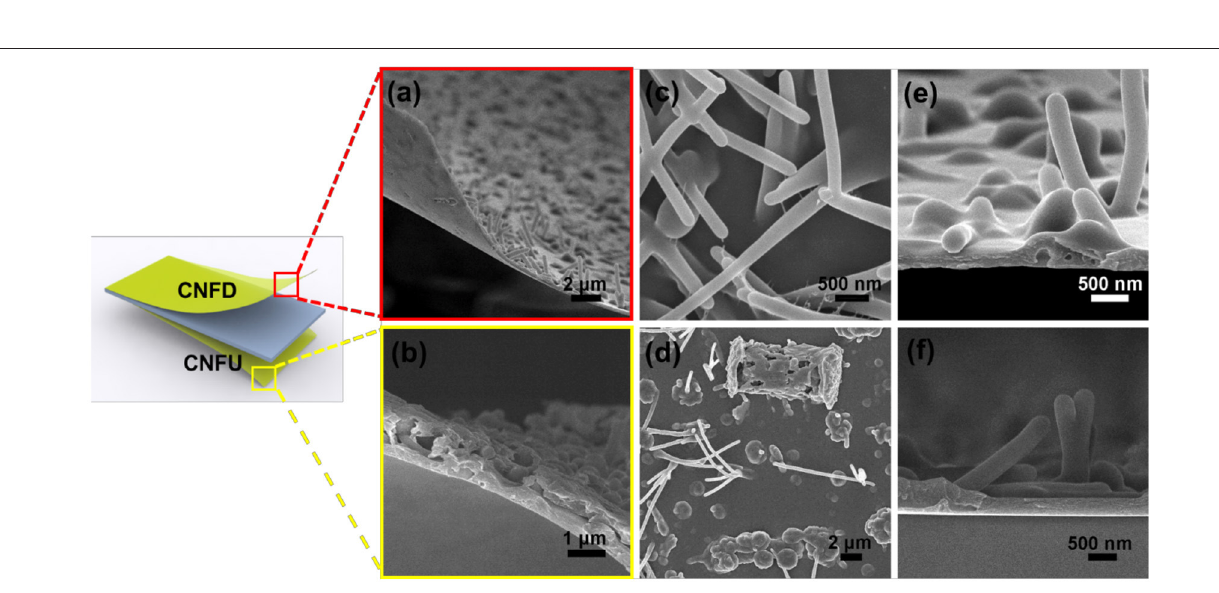
deposition process is shown in Scheme S1 . In brief, the successful uniform nucleation and micrometer-scale